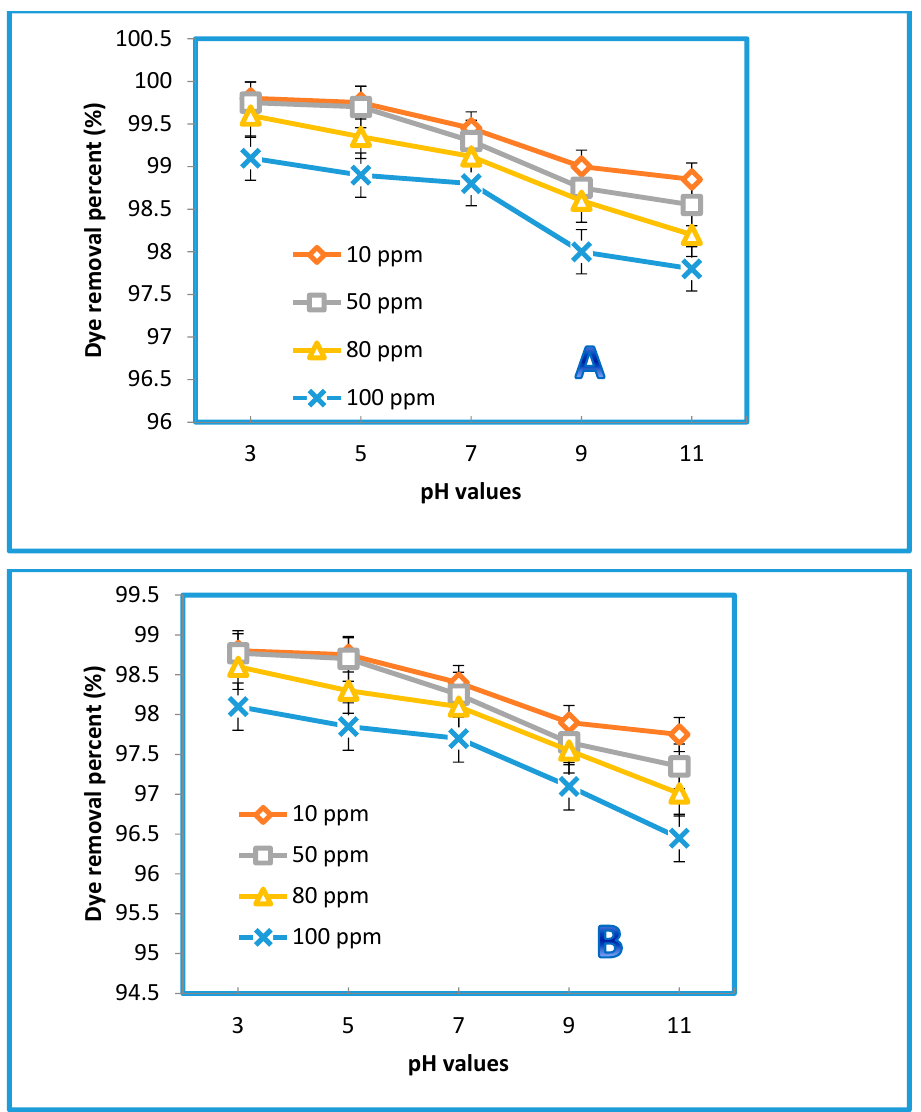
Figure 13. Effect of pH on the dye removal percent of membrane prepared from % 0.5 GO, at 3 bar, 25 ◦ C, for AB-210 ( A ) and RB ( B ).